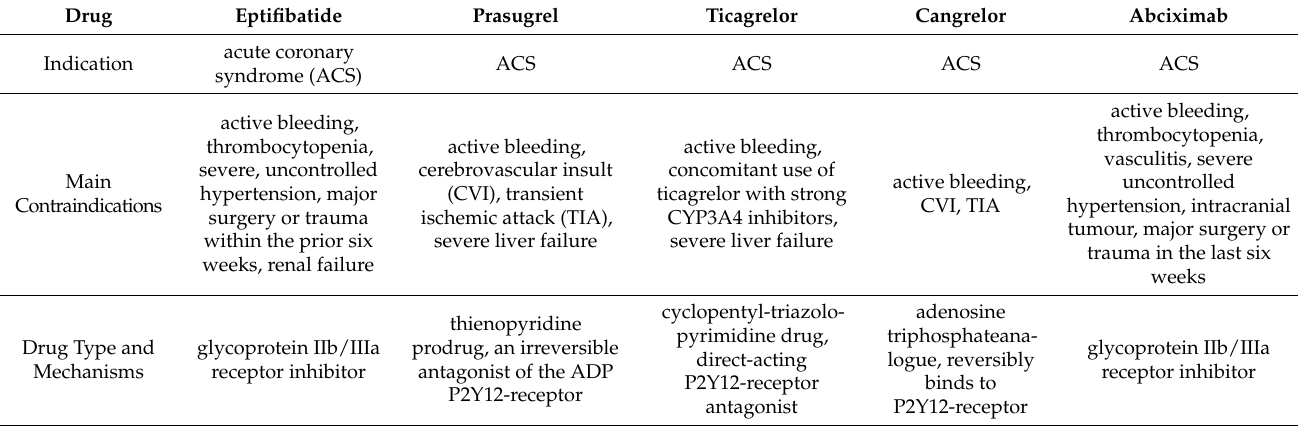
Table 1. Comparison of different antiplatelet drugs